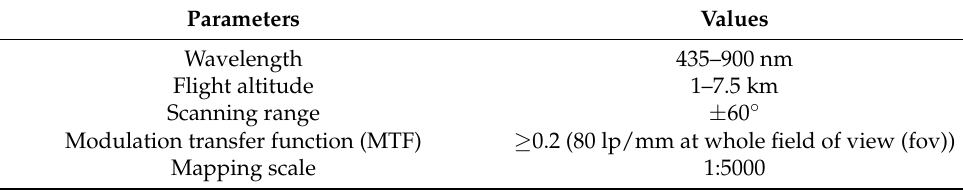
Table 1. Main technical indicators of the airborne-mapping